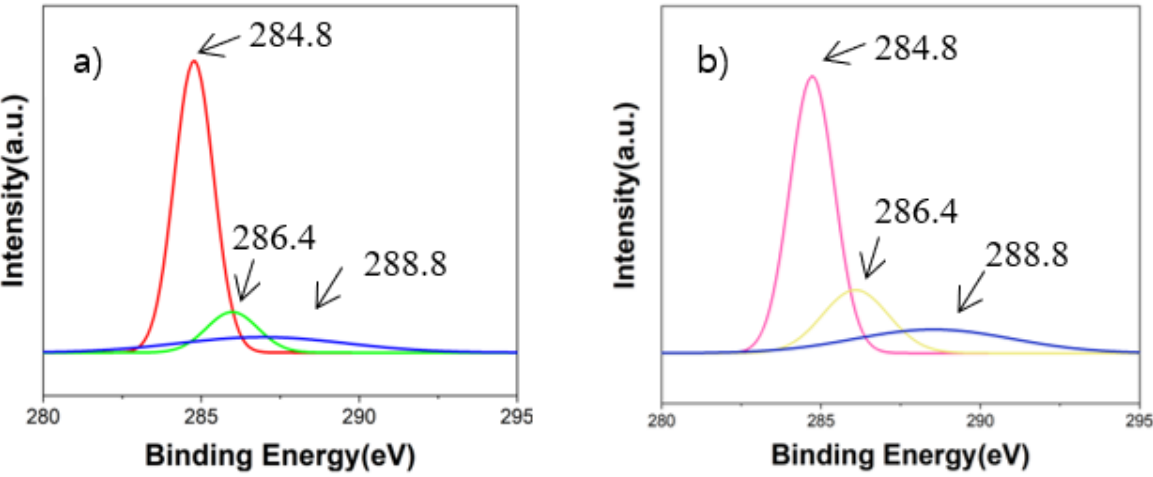
Figure 8. Binding energy peaks of the carbon atoms and carbon compounds on the SiO 2 wafer: ( a ). Base; ( b ) After vacuum carbon vaporization experiment.